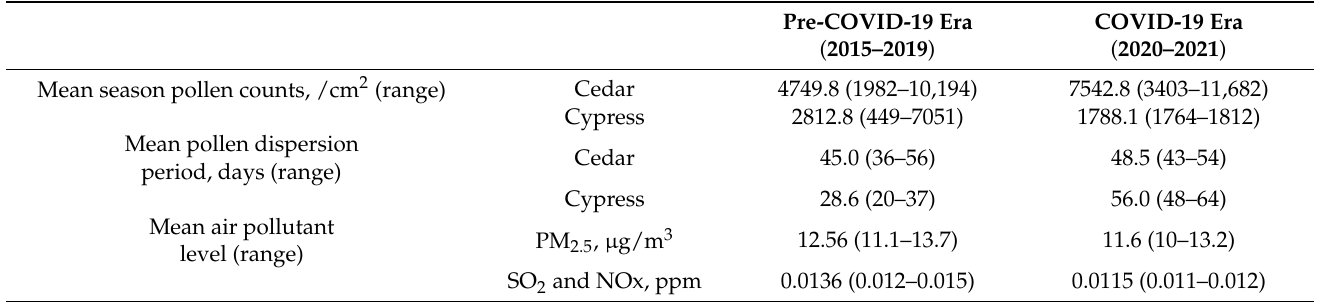
Table 2. Comparison of pollen dispersion counts and periods, and air pollutants in Hiroshima